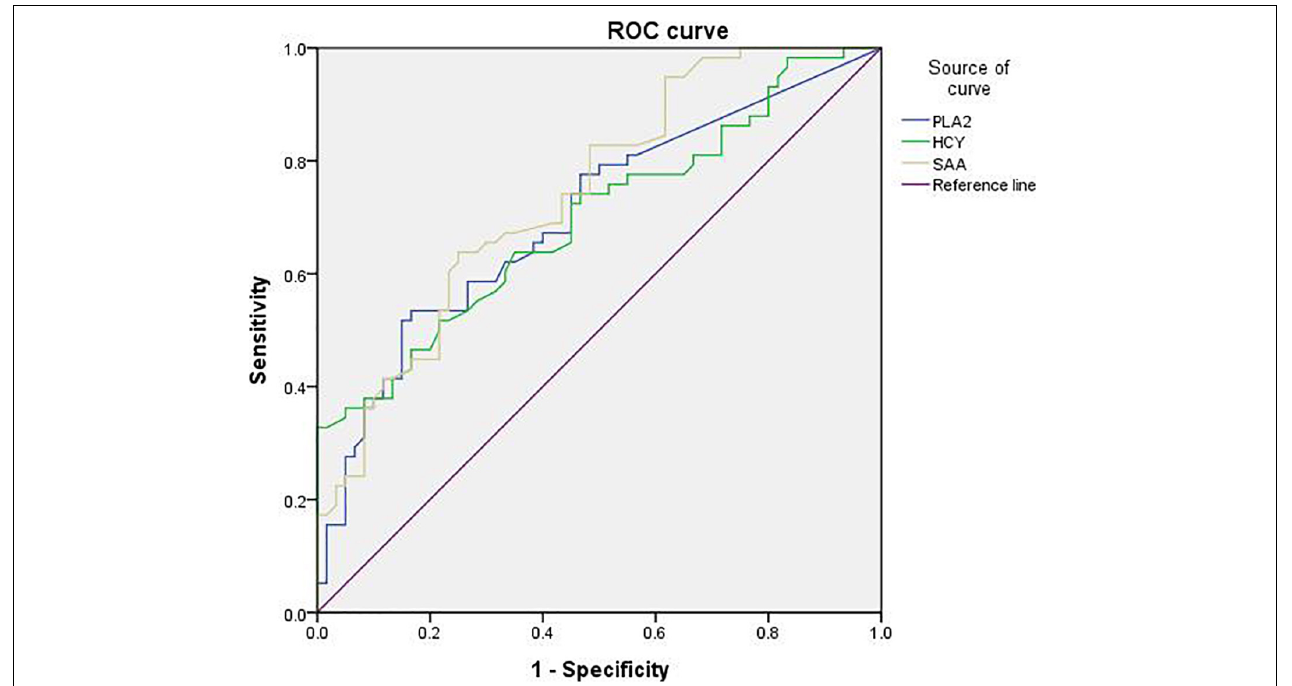
FIGURE 1 | The ROC curve of Lp-PLA2 for discrimination between patients in PD and control